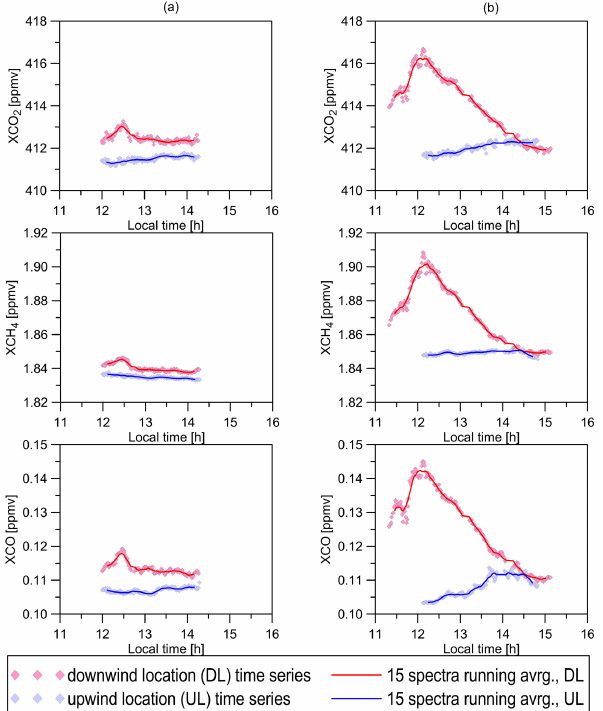
Figure 8. Time series of X gas for 4 April (a) and 25 April (b) at the clean location of FTSs (blue dots) and at the polluted location of FTSs (red dots). Solid lines of corresponding colours denote the 15min running